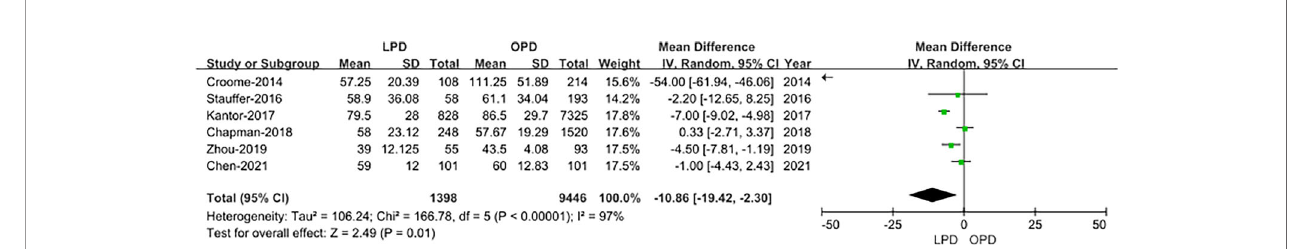
FIGURE 8 | Forest plot of the comparison of LPD versus OPD for time to starting adjuvant chemotherapy after surgery.